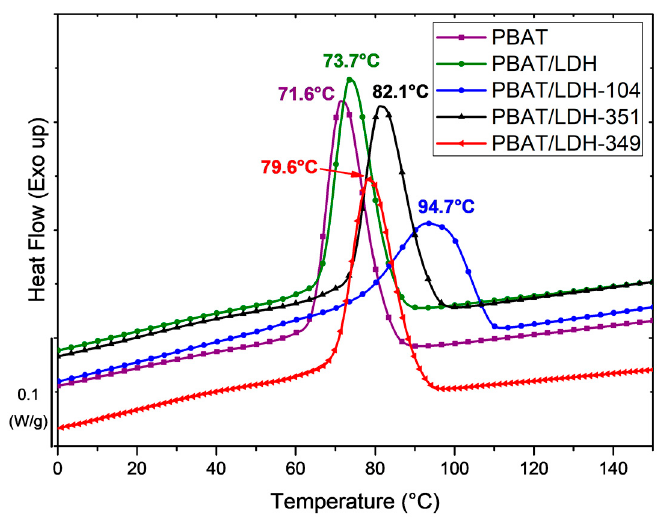
Figure 7. Differential scanning calorimetry (DSC) curves showing the crystallization temperatures T c of neat PBAT and PBAT containing 5 wt % of untreated LDH and LDH-ILs.